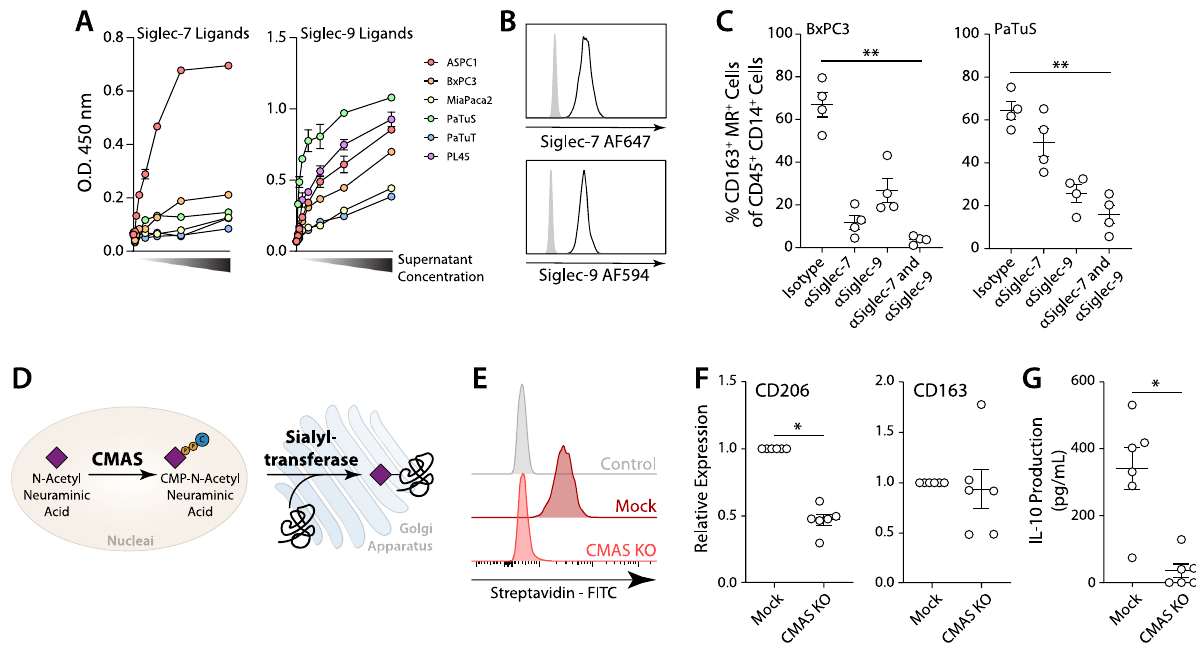
Fig. 5 Sialic acids contribute to the differentiation of tumour moMac by interacting with Siglec-7 and Siglec-9 in monocytes. A Presence of Siglec ligands in the supernatants of cell lines analysed by ELISA. B Histogram of Siglec-7 and Siglec-9 expression in circulating monocytes as analysed by fl ow cytometry, non-stained cells in grey and blood-derived monocytes from healthy donors in black line. C Analysis of CD163 + MR + CD45 + CD14 + cells after the co-culture of tumour cell lines with monocytes in the presence of Siglec-7 and Siglec-9 blocking antibodies. Data presented as mean values ± SEM. Statistics: Friedman test (** p ≤ 0.01). D Representation of the role of CMAS in cellular sialylation. E Flow cytometric analysis of α 2,3 linked sialic acids using MAAII lectin staining in the BxPC3 CMAS knockout and mock cells. F Expression of CD206 and CD163 in CD45 + CD14 + cells after co-culture of monocytes with mock and CMAS KO cell lines. Relative expression was calculated with respect to the mock cell lines (set as 1). Data presented as mean values ± SEM. Statistics: Two-tailed Wilcoxon test (* p < 0.05). G) IL-10 production after co-culture was analysed by ELISA. Data presented as mean values ± SEM. Statistics: Two-tailed Wilcoxon test (* p <